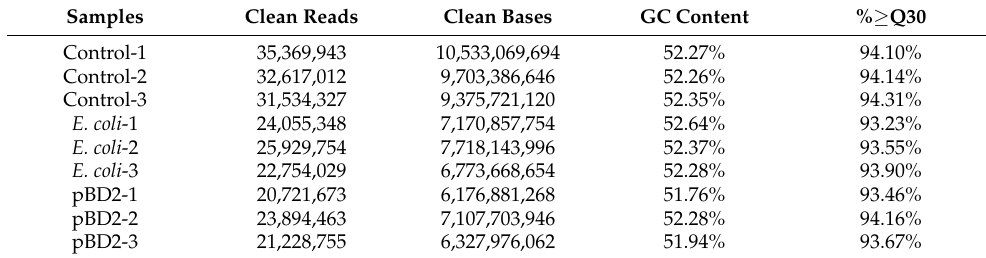
Table 1. Sequencing data statistics.